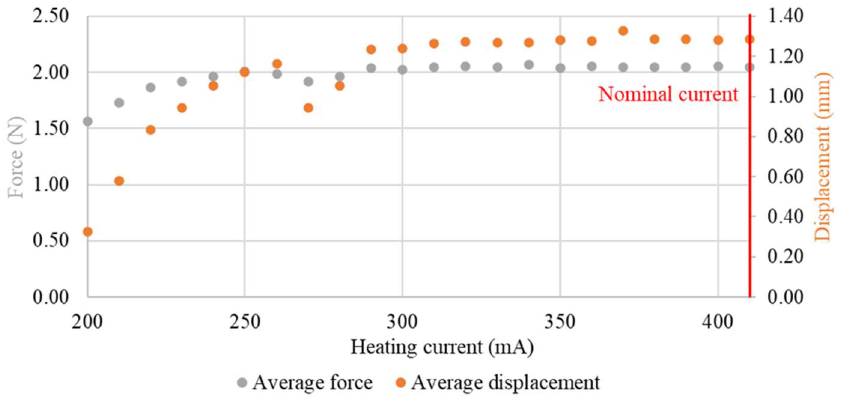
Figure 13. Relationship of average force and average displacement with heating current (test sample diameter, 150 μm).